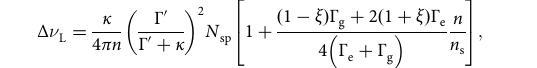
Hence, the difference is also zero for the inhibited laser. This result demonstrates that the approximation used in the main text is reasonable. To further characterize the output laser power as a function of the phase shift at different pumping ef fi ciencies and atomic densities, the pumping light intensity and the vapor-cell temperature are adjustable, as depicted in Fig. 2a. According to Eq. (7), the intracavity effective atomic number is in fl uenced by both the pumping light intensity and the vapor-cell temperature, while the Rabi frequency of the pumping laser is relative to the pumping light intensity, which is described as ffiffiffiffiffiffiffiffiffiffiffiffiffi q 3 λ 21 3 Γ 21 I Ω ¼ . N eff and Ω as functions of/and N eff vs. T are shown in Fig. 7a, b, 2 π hc respectively.